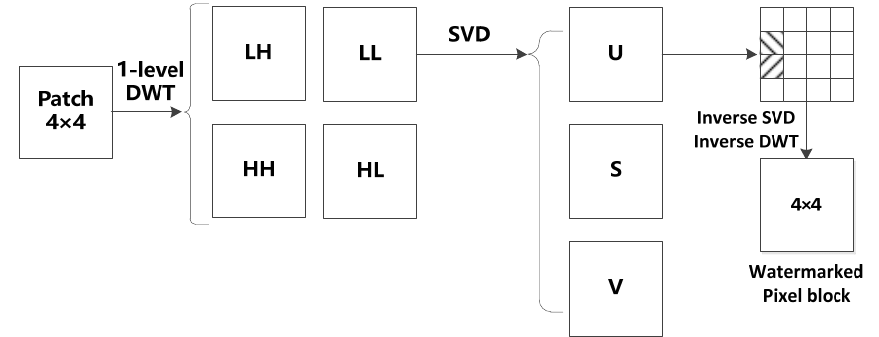
Figure 5. The DWT-SVD embedding watermark process.